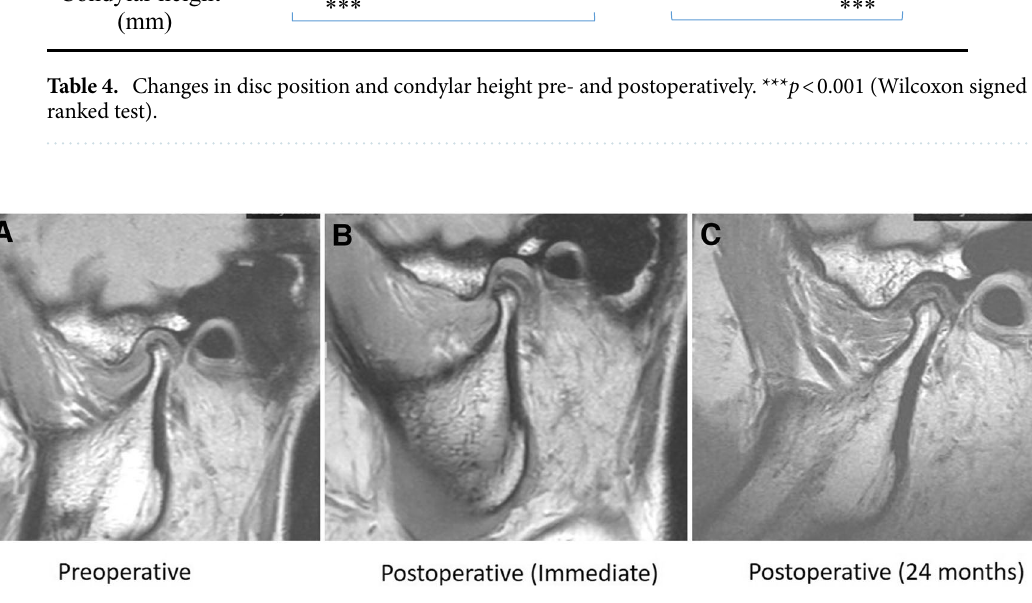
Figure 4. MRI scans of a 17-year-old female patient with ADD on the left side. ( A ) Preoperative MRI image, ( B ) Immediate postoperative MRI image showing successful disc repositioning, ( C ) Stable disc position with condylar bone remodeling at 24 months of postoperative